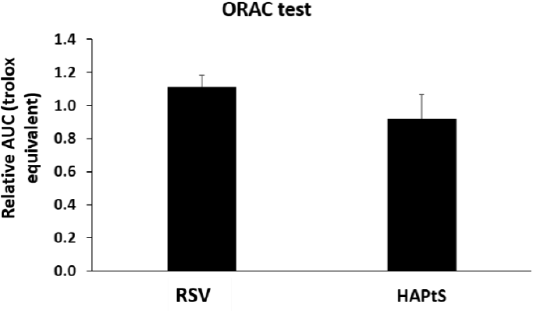
Figure 4. Antioxidant capacity measurement of trans -resveratrol (RSV) and chemically synthesized molecules (HAPtS).